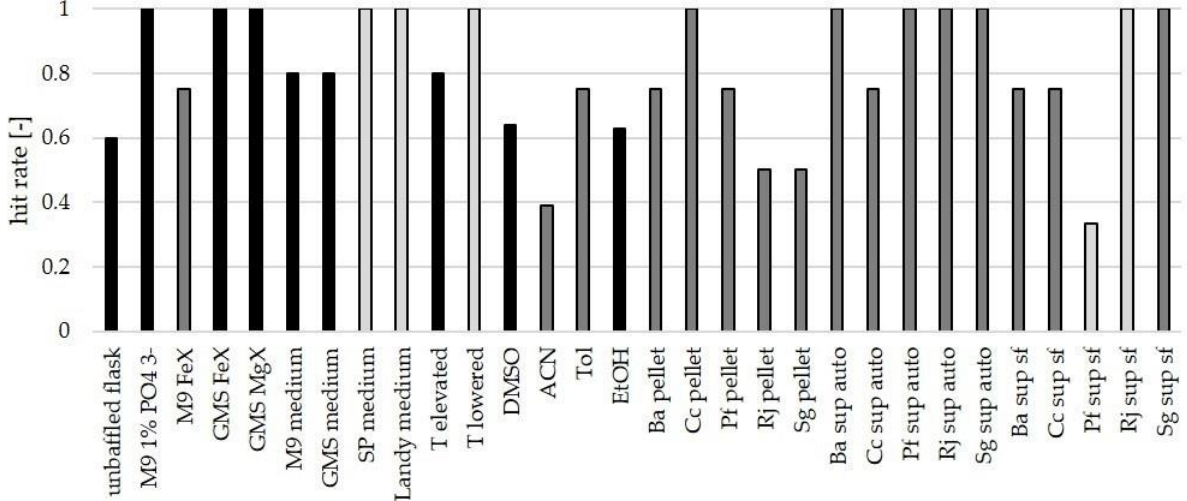
Figure 6. Hit rates for all tested culture conditions. Black bars: sample size n = 5 strains, dark grey bars: n = 4, light grey bars: n = 3.